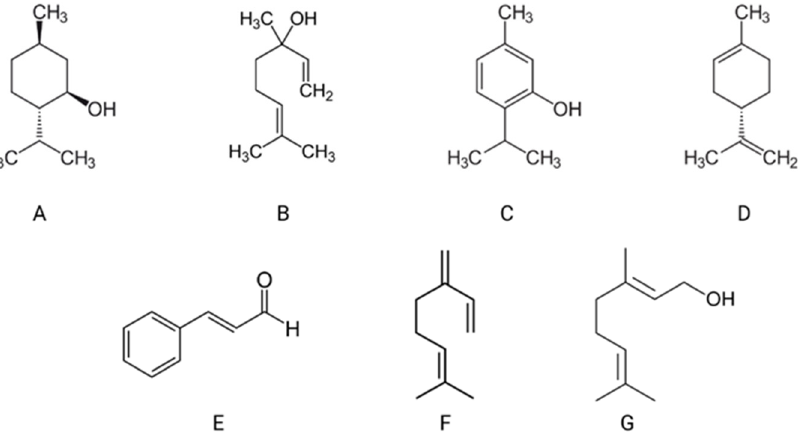
Figure 1. Examples of the main compounds of essential oils: menthol ( A ), linalool ( B ), thymol ( C ), limonen ( D ), geraniol ( E ), cinnamaldehyde ( F ), myrcene ( G ), own elaboration [21].